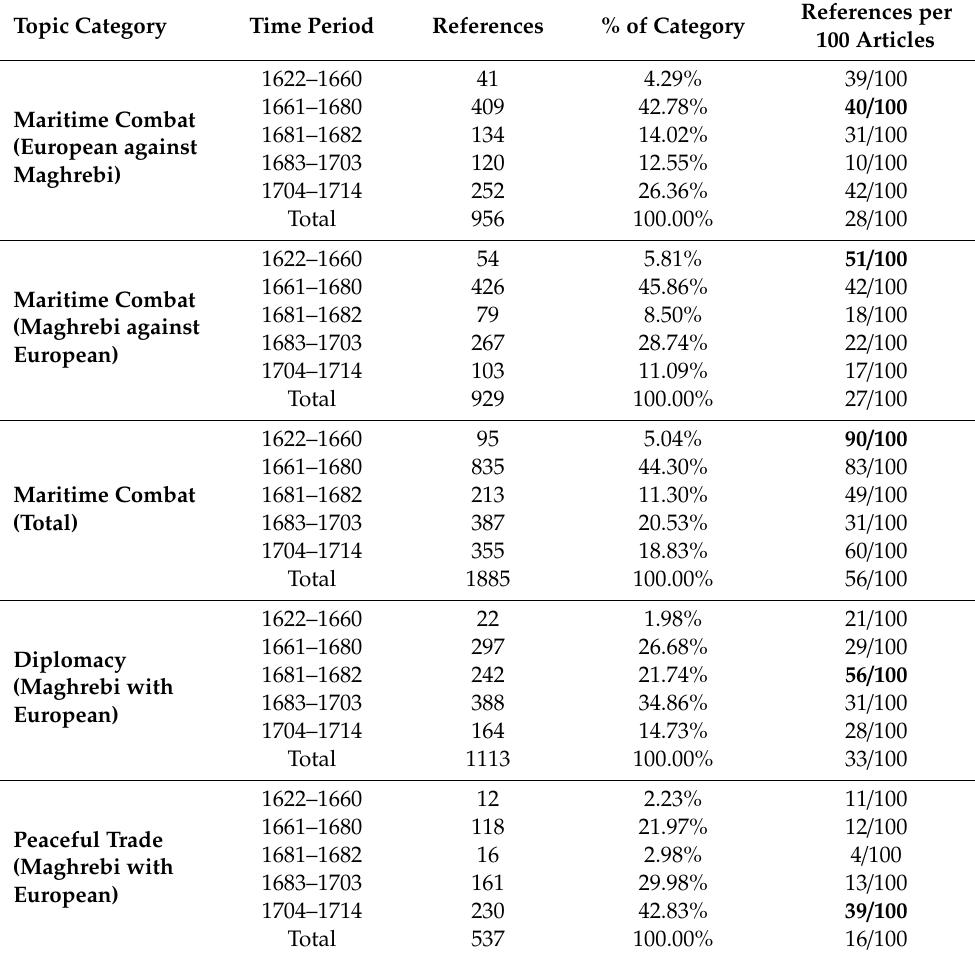
Table 5. References to maritime combat, diplomacy and trade by period (British and European relations, highlighting period with most references for each